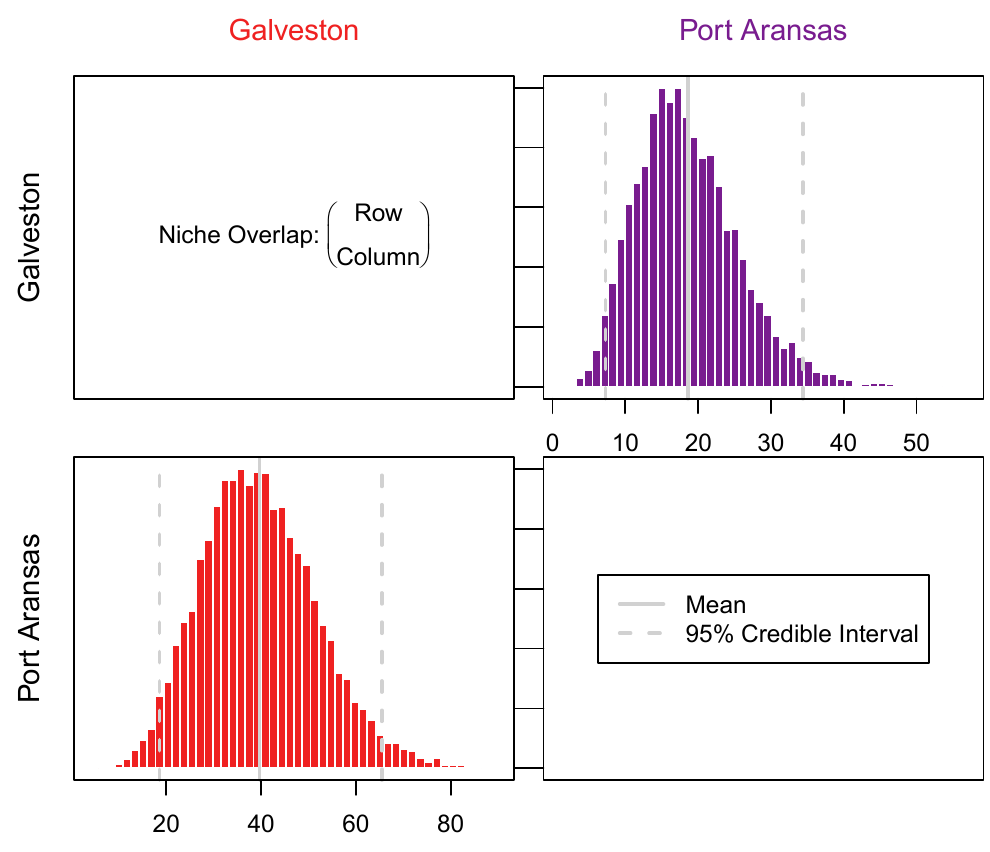
Figure 6. Niche overlap measured pairwise across sheepshead from both locations. Niche overlap was estimated using the 95% confidence interval of the total niche size using 10,000 random Monte Carlo draws of the niche size derived from the combined stable isotope ( δ 13 C, δ 15 N, and δ 34 S) values measured in liver samples. Additionally, niche size was determined as row over column to estimate the proportion of sheepshead from one location (row) that was overlapped by sheepshead from another location (column).